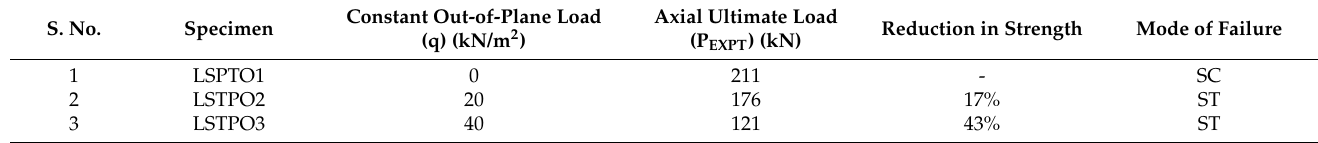
Table 9. Influence of out-of-plane load on the axial load of GFRP-stiffened composite plates with cutout. S.